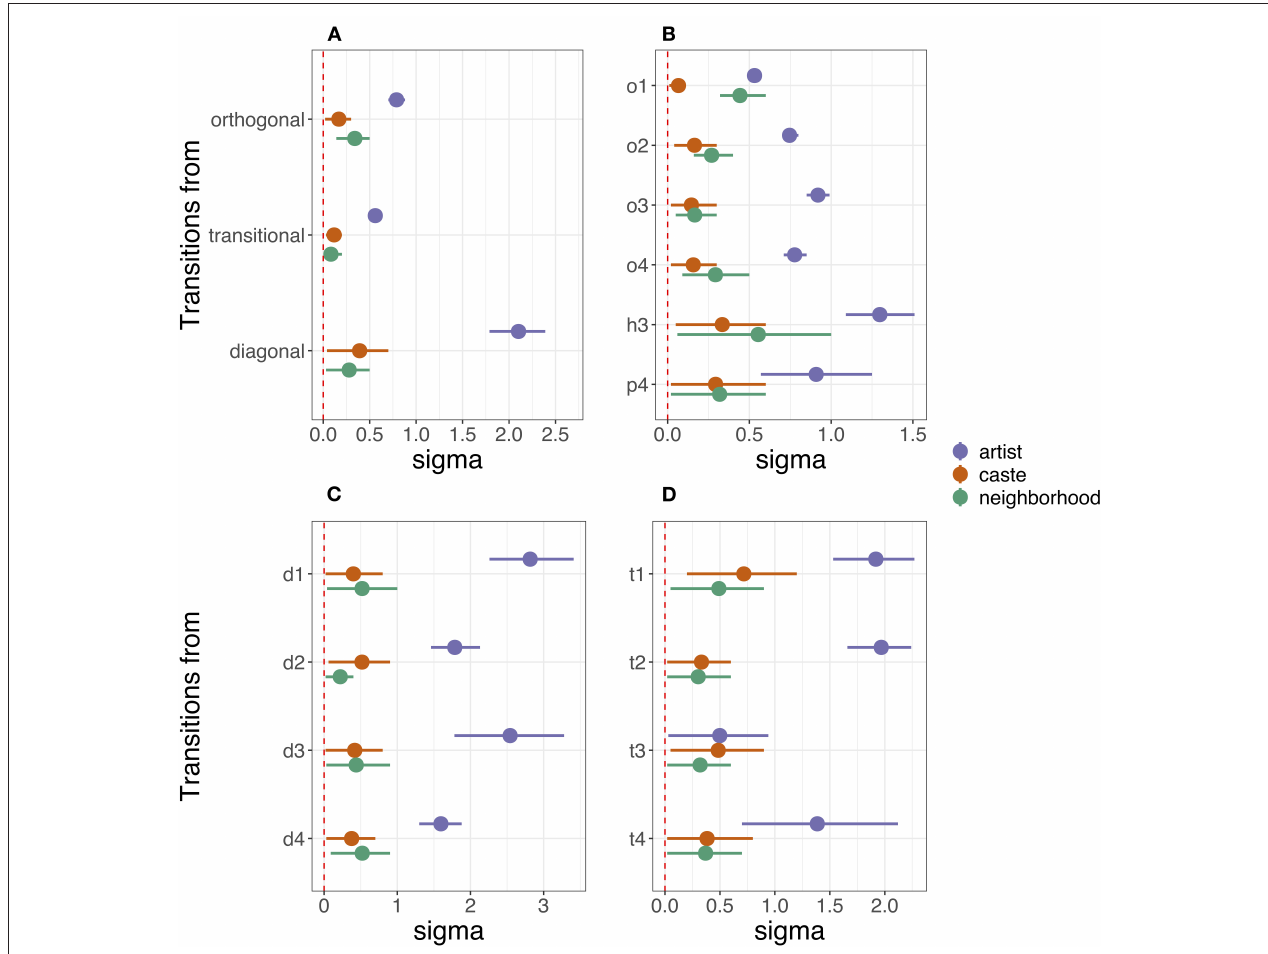
FIGURE 5 | Posterior Coefficient Plots displayed as the 90% Highest Posterior Density Interval (HPDI) of the posteriors of sigma estimates (i.e., standard deviation of the random effects) associated with variation due to artists, caste, and neighborhood. Transitions from geometric spaces (A) and from individual gestures (B–D) are shown on the y -axis.